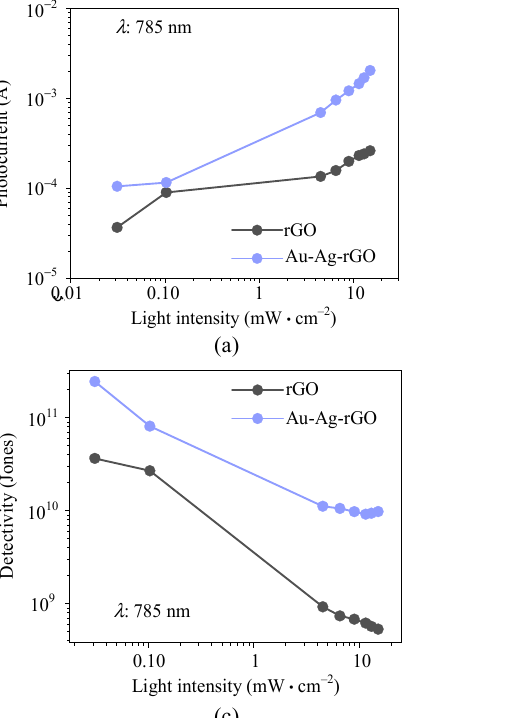
Fig. 6 Light intensity-dependent photocurrent (a), responsivity (b), detectivity (c), and EQE (d) of bimetallic NPs and bare rGO photodetectors under the illumination of 785